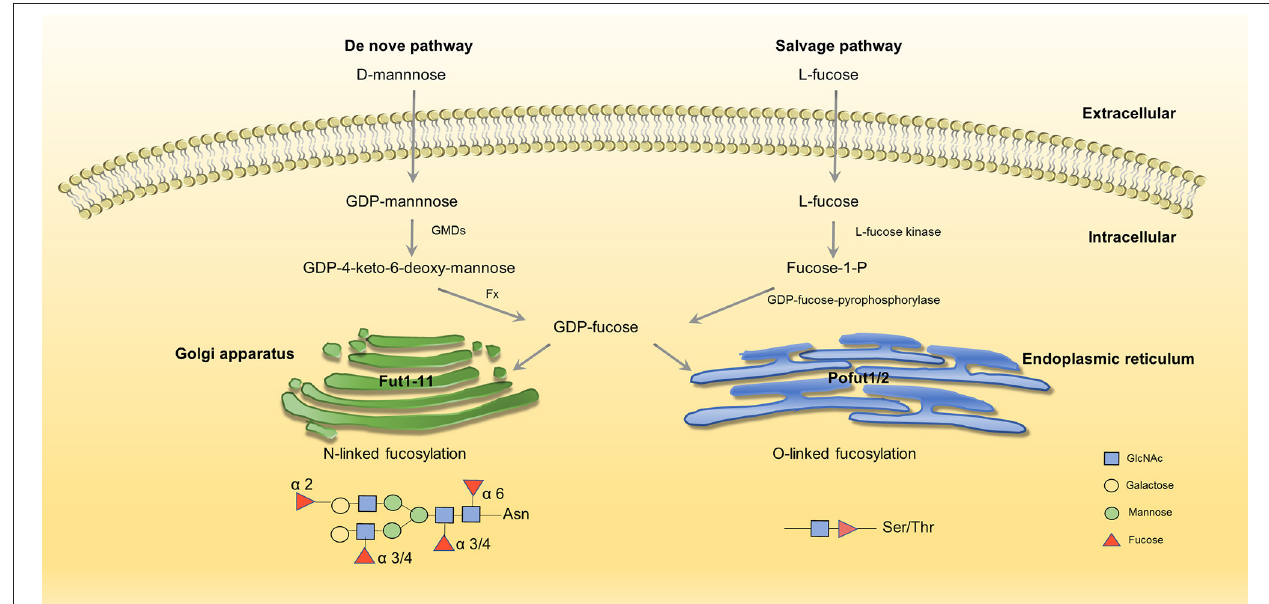
FIGURE 1 | Two synthesis pathways of fucosylation. GDP-fucose is either synthesized from GDP-mannose ( de novo pathway, left) or L-fucose (salvage pathway, right) before being transported into Golgi/ER through transporters ( 35, 36). No permissions were required to use the